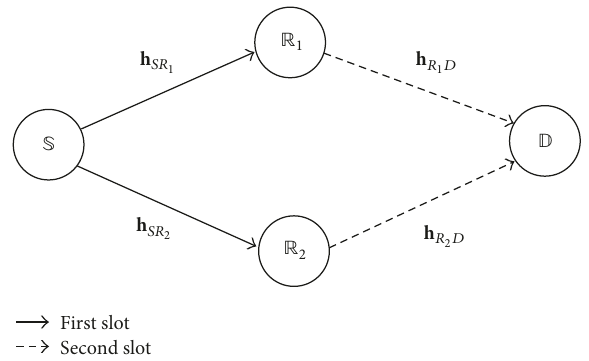
Figure 1: Diagram for cooperative diversity with two relay nodes.